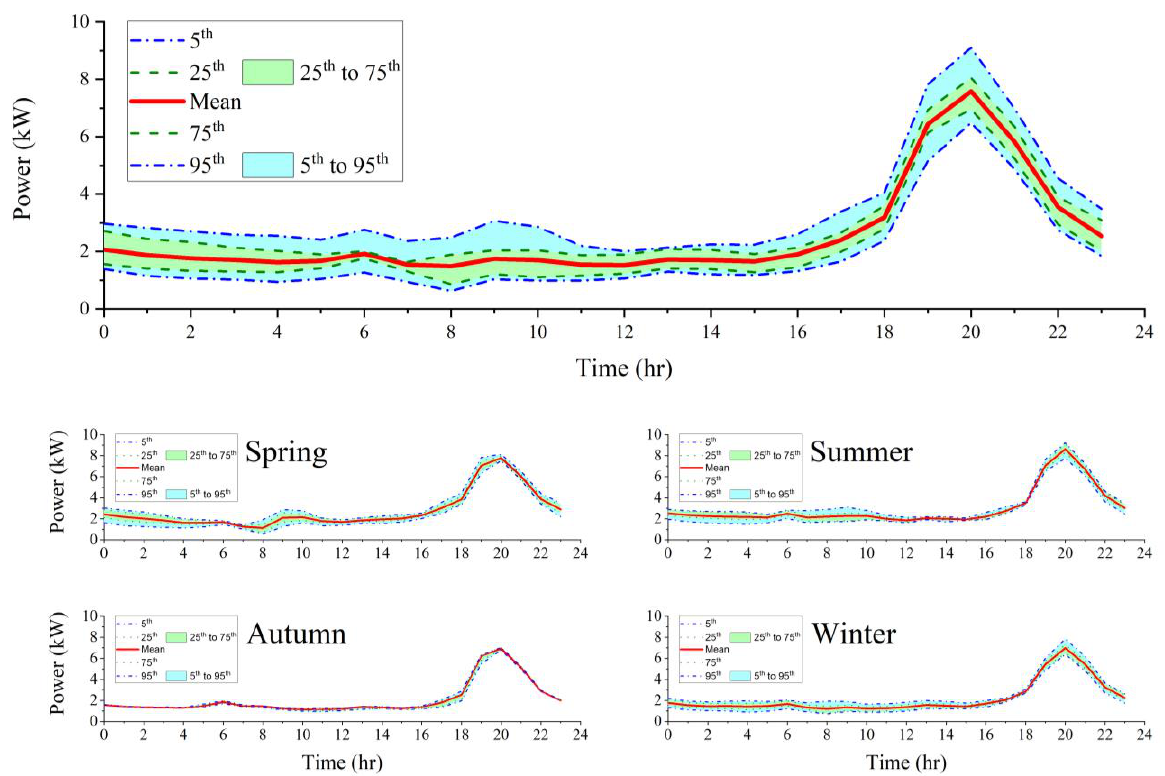
Figure 16. Average annual and seasonal whole mini-grid (total) daily demand load profiles (with percentile ranges).